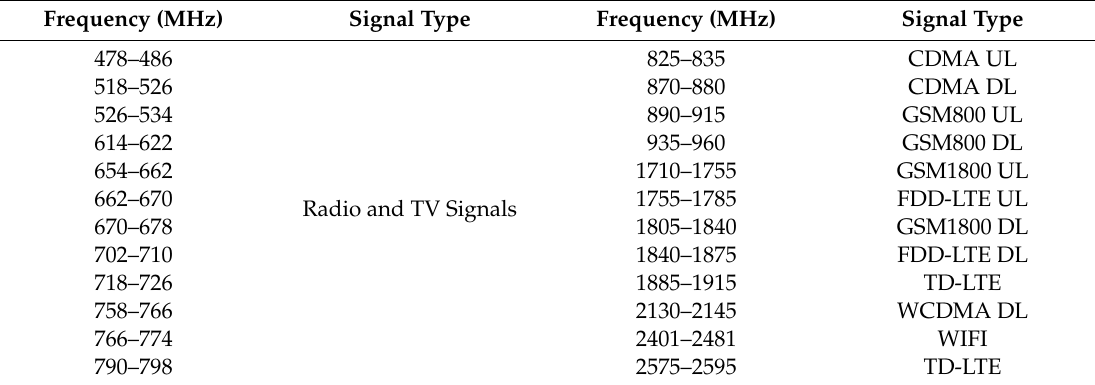
Figure 4. Spectrums of the noise measured near welder robot. ( a ) Amplitude spectrum of noise; ( b ) Power spectrum of noise. Table 3. Frequency spectrums occupancy of communication signals.